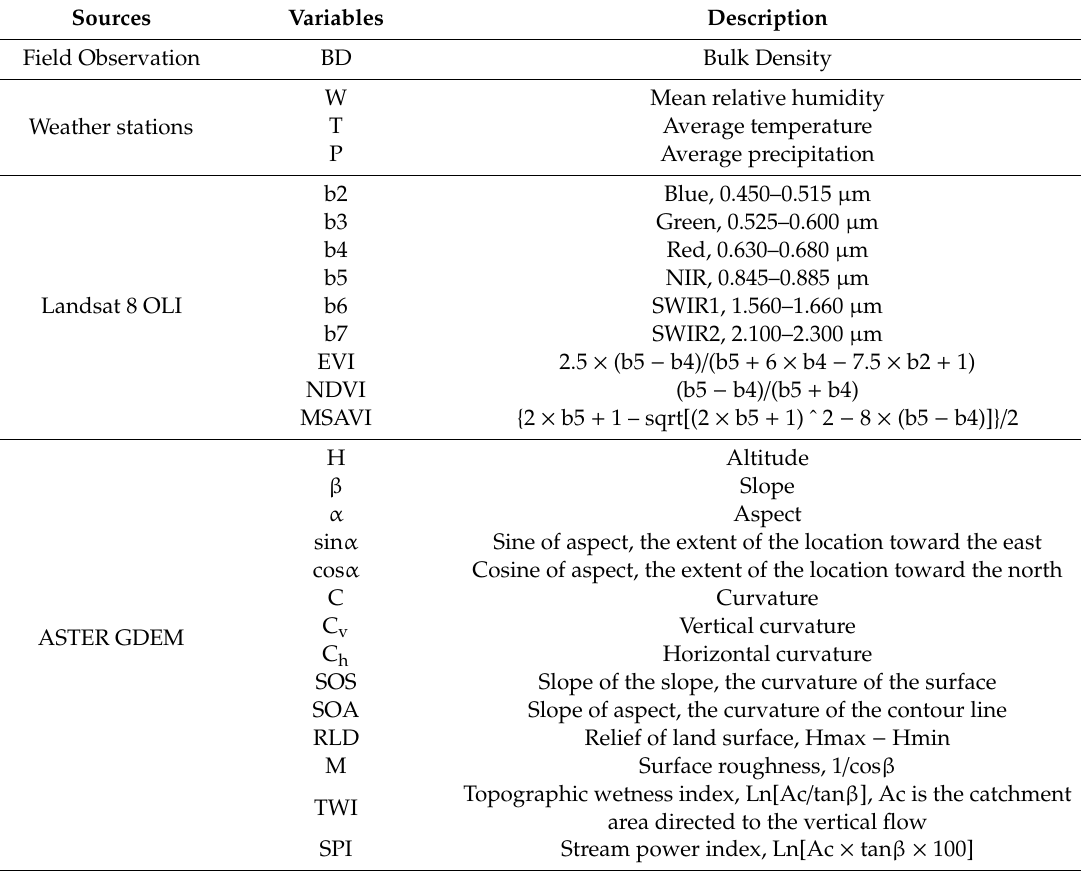
Table 1. Environmental variables for soil organic carbon (SOC)